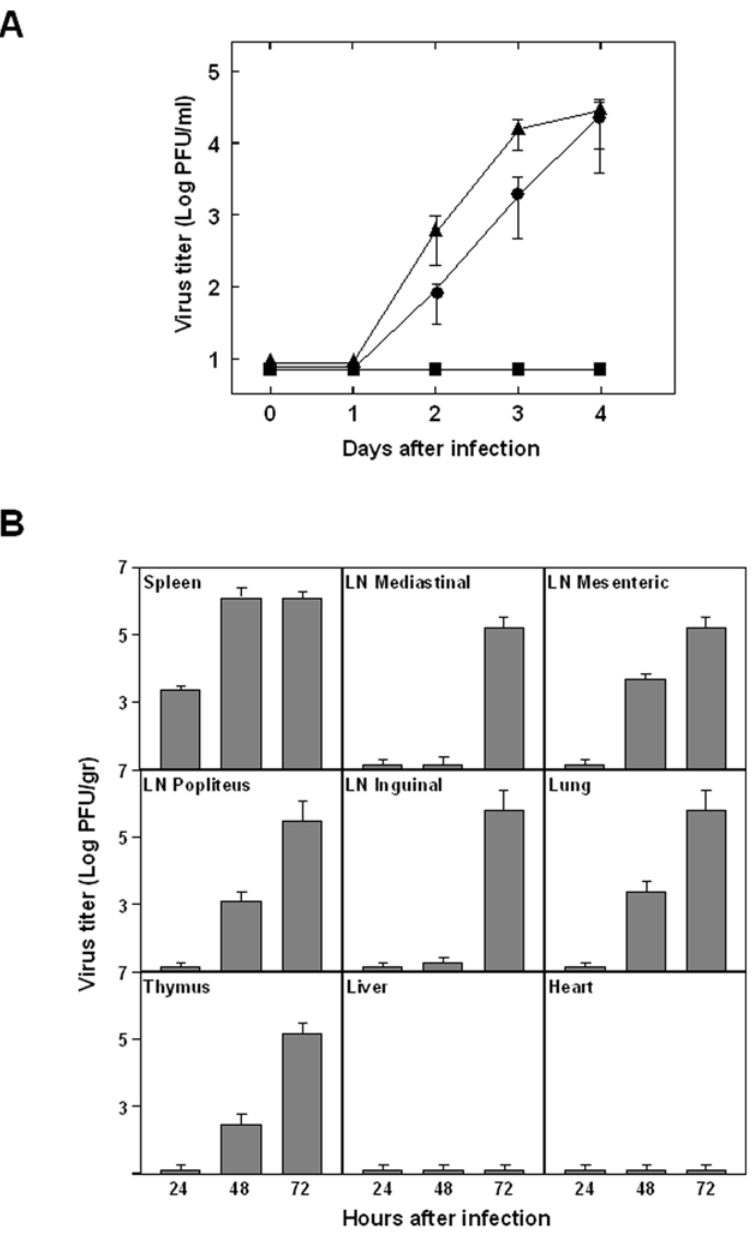
Figure 2. BTV-4 titers in blood and several organs of infected IFNAR ( 2 / 2 ) mice. (A) Titers of BTV-4 recovered in blood after intravenous infection with 10 2 ( & ), 10 3 ( N ), or 10 4 ( m ) PFUs of BTV-4. Virus was extracted from blood and determined as described in Materials and Methods. Each point represents the mean values of the viral titer of six animals, and standard deviations are shown as error bars. (B) Mice (8 weeks old, 6 mice per group) were inoculated intravenously with 10 4 PFUs of BTV-4. Virus was extracted from the indicated tissues at 24, 48 and 72 hours after infection for virus titration. Standard deviations are given. Procedures are detailed in Materials and methods.